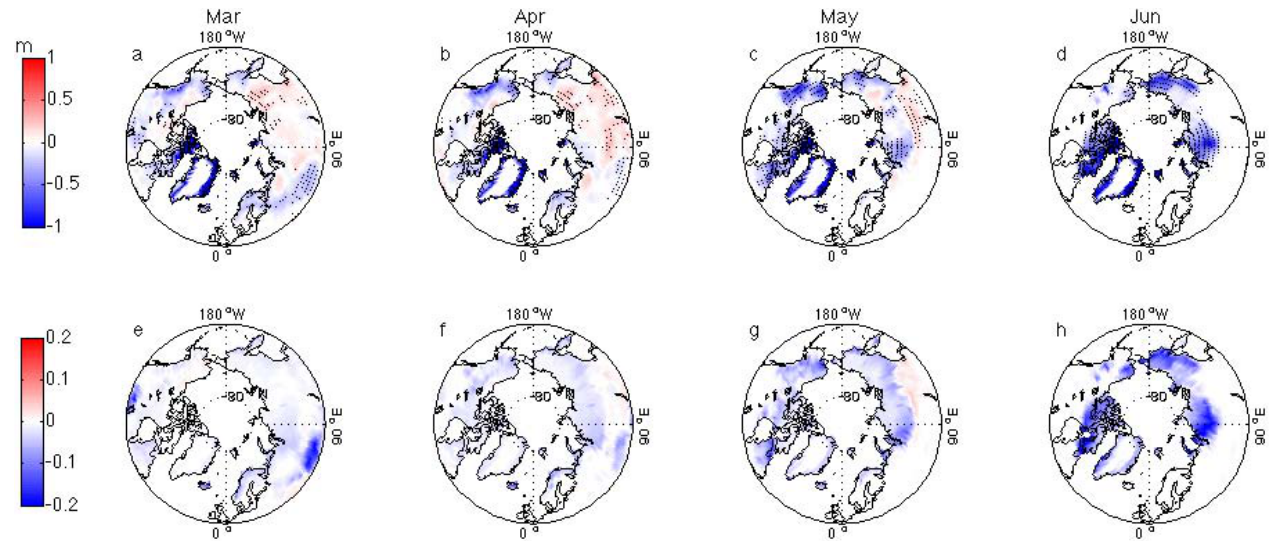
Fig. 8. March–June snow water equivalent thickness difference (a–d) due to light-absorbing particles in snow and sea ice, and the overall surface albedo (decimal 0 to 1) difference between runs with and without light-absorbing particles in snow and sea ice. (e–h) .